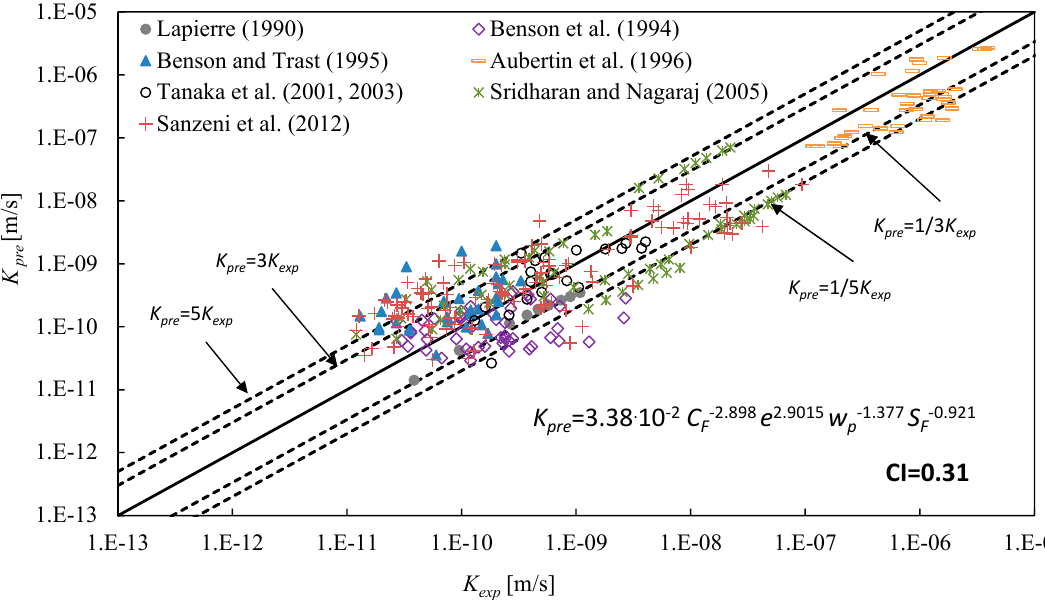
Figure 4. Experimental ( K exp ) and predicted value ( K pre ) of the saturated hydraulic conductivity as determined by Equation (21).